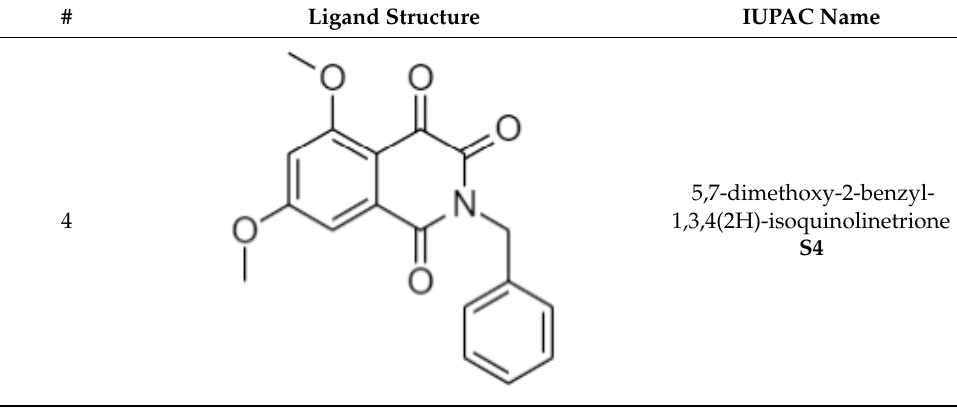
Table 2. Sensor membrane compositions